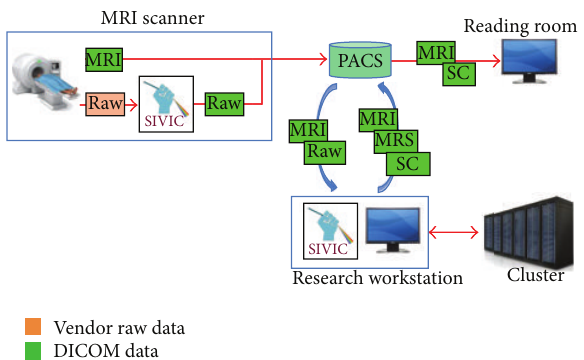
Figure 10: Off-scanner MRSI workflow. SIVIC command line tools running on the scanner convert vendor raw MRS data to DICOM Raw Data Storage SOP instances. Anatomical MRI and raw DICOM data is sent to PACS. A research workstation retrieves DICOM images from PACS. MRSI data is reconstructed and DICOM MRS, DICOM MRI metabolite maps and DICOM secondary capture (SC) images are exported and sent to PACS. DICOM SC and DICOM MRI data is viewed in the reading room. DICOM MRI (anatomical and metabolite maps) and DICOM MRS images may be viewed on a research workstation running SIVIC or other DICOM